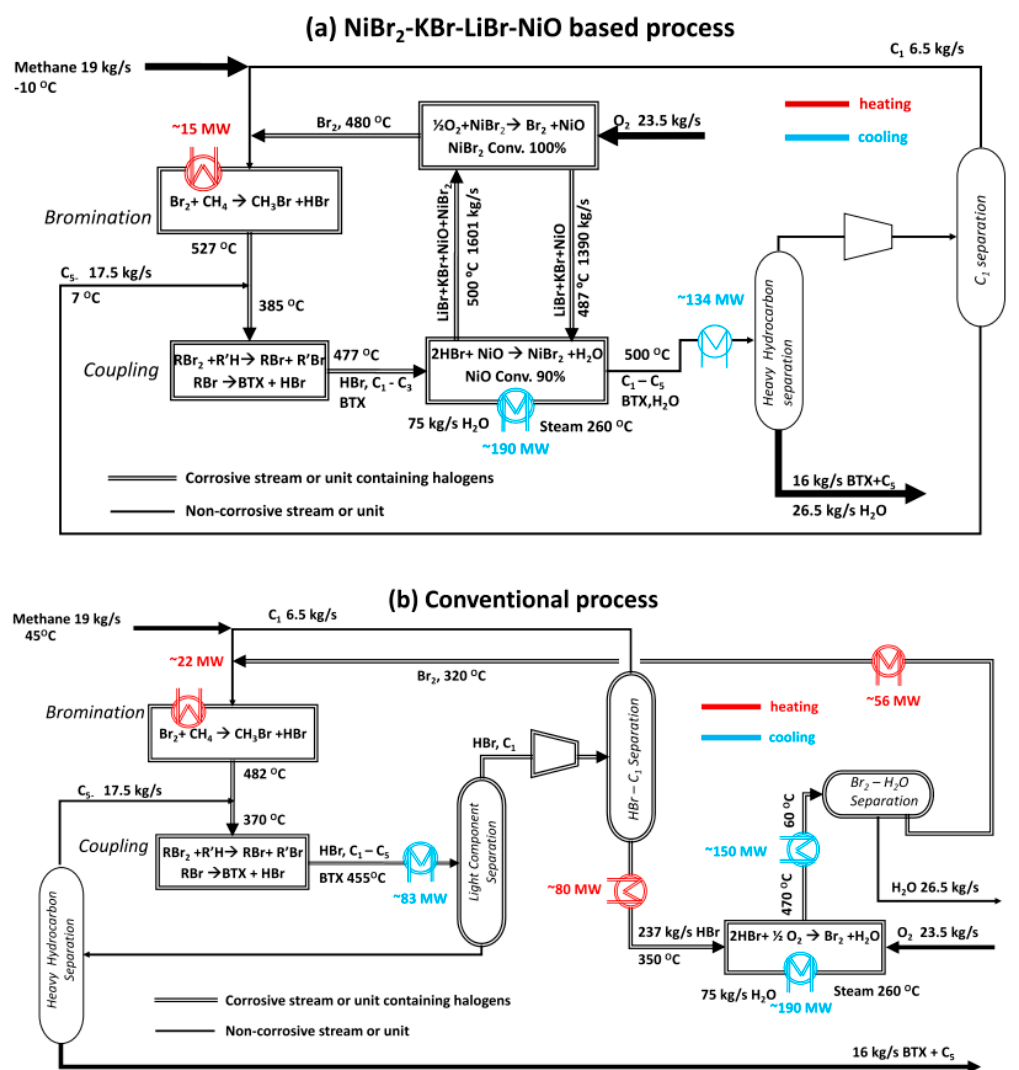
Figure Figure 7. The proposed and conventional process for the conversion of methane to higher hydrocarbons [18].